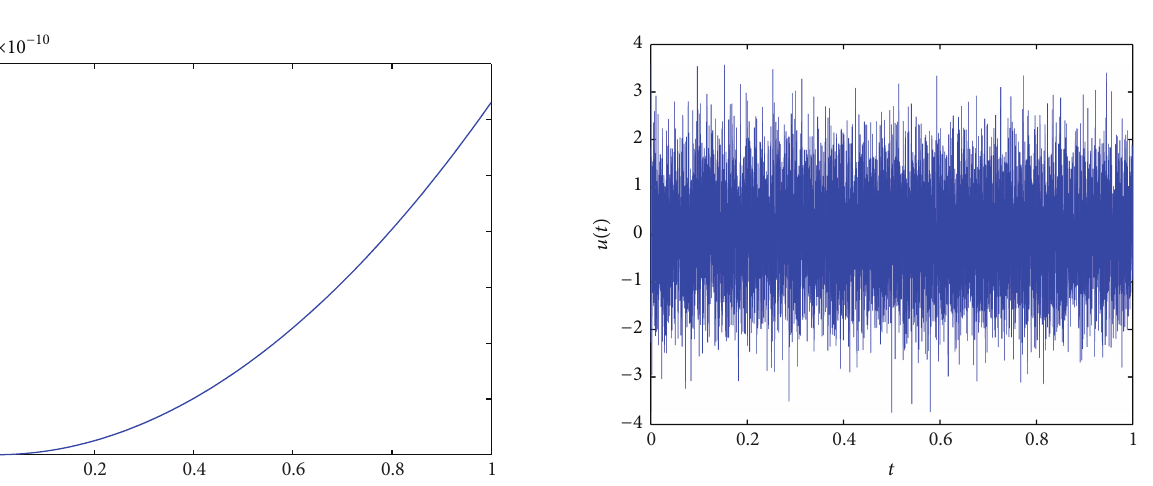
Figure 2: The displacement with a Wiener process, the numerical simulation of (60), where 𝛼 = 1.5 , 𝛽 = 0.8 .